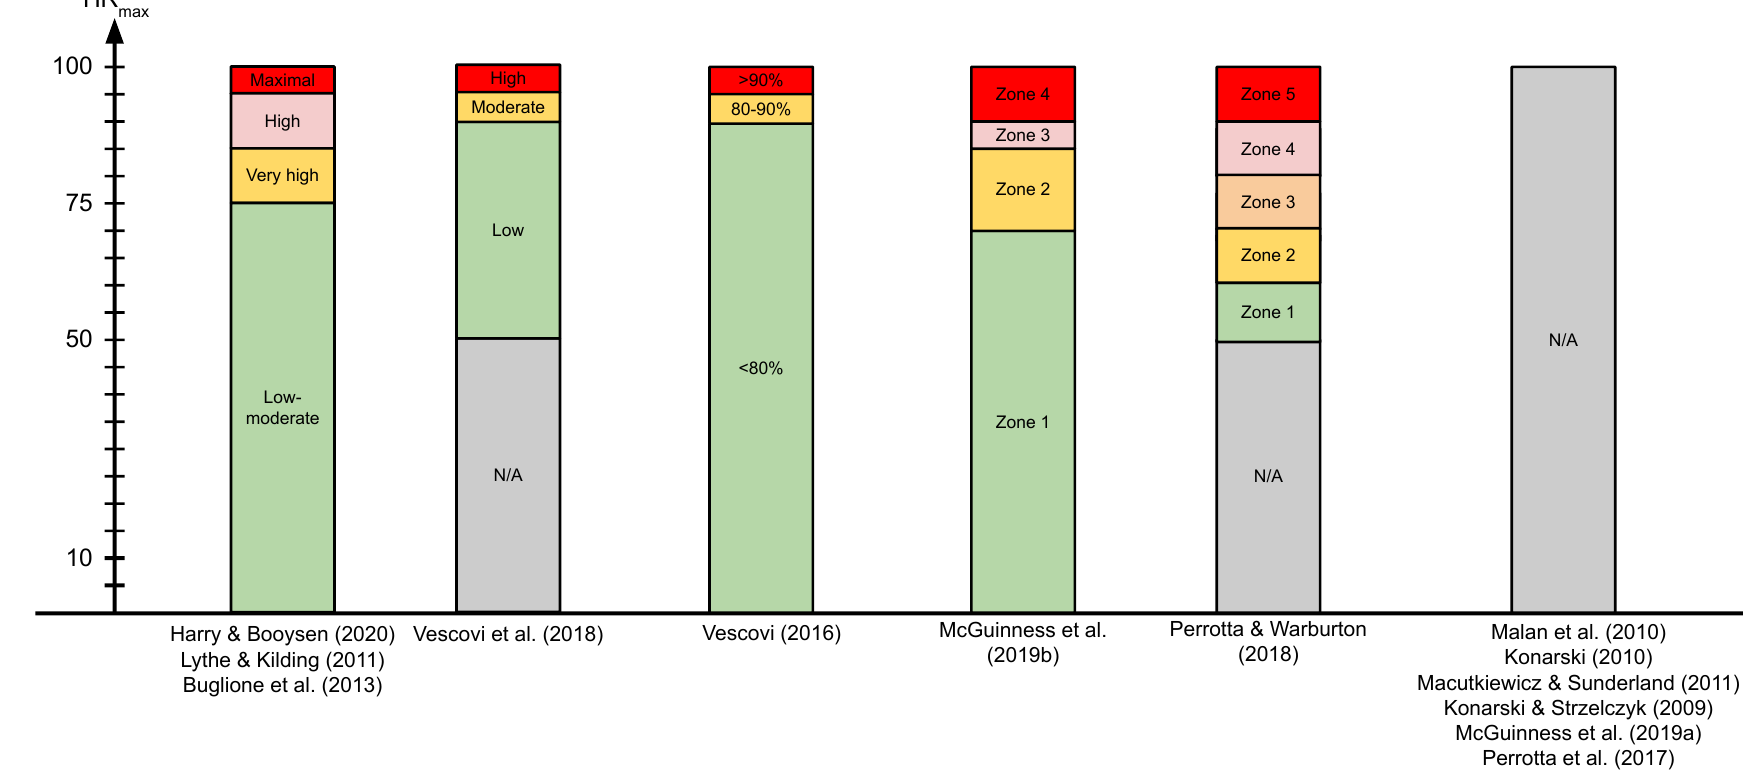
Figure 3. Heart rate bands in studies that used heart rate monitors. HR max : maximal heart